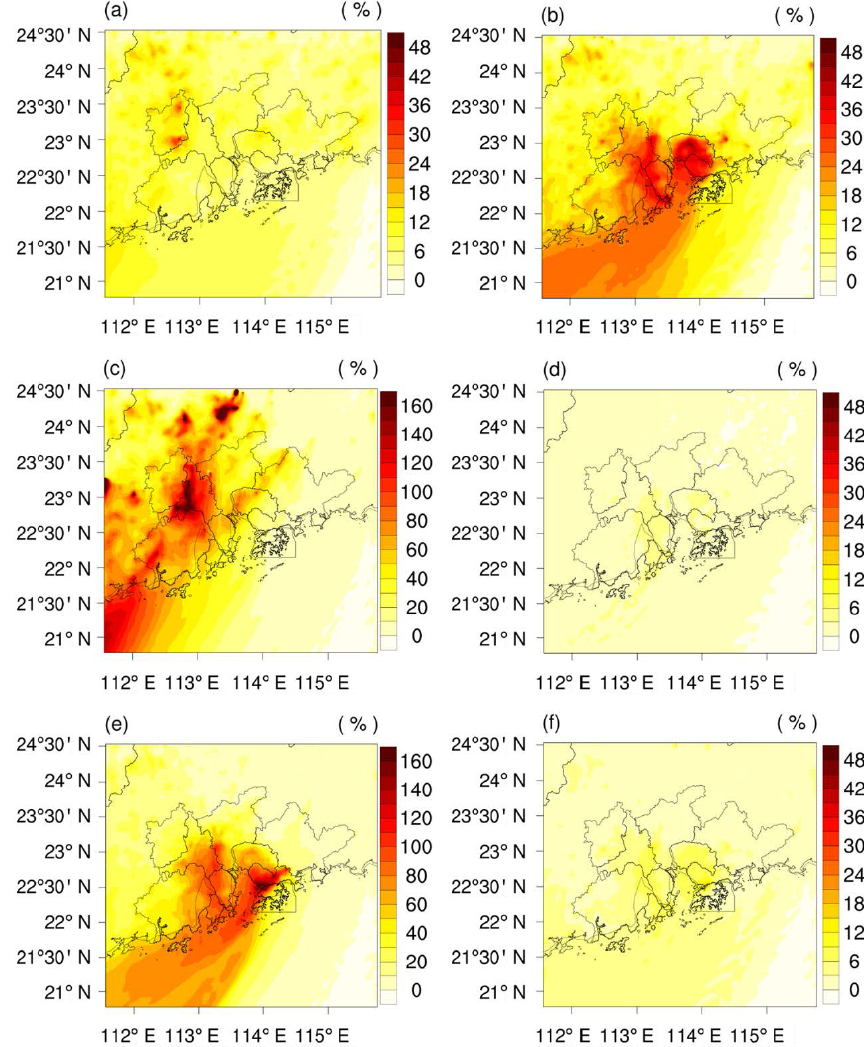
Figure 9. Relative difference of SOA between CASE runs and BASE: (a) CASE7, (b) CASE8, (c) CASE9, (d) CASE10, (e) CASE11, (f)